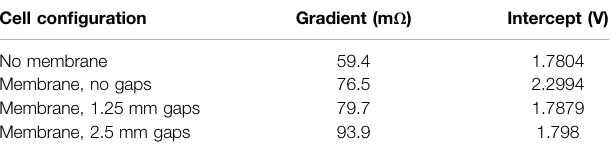
TABLE 2 | Gradients and intercepts of electrolysis voltage curves, indicating ohmic resistance and voltage at which signi fi cant electrolysis fi rst takes